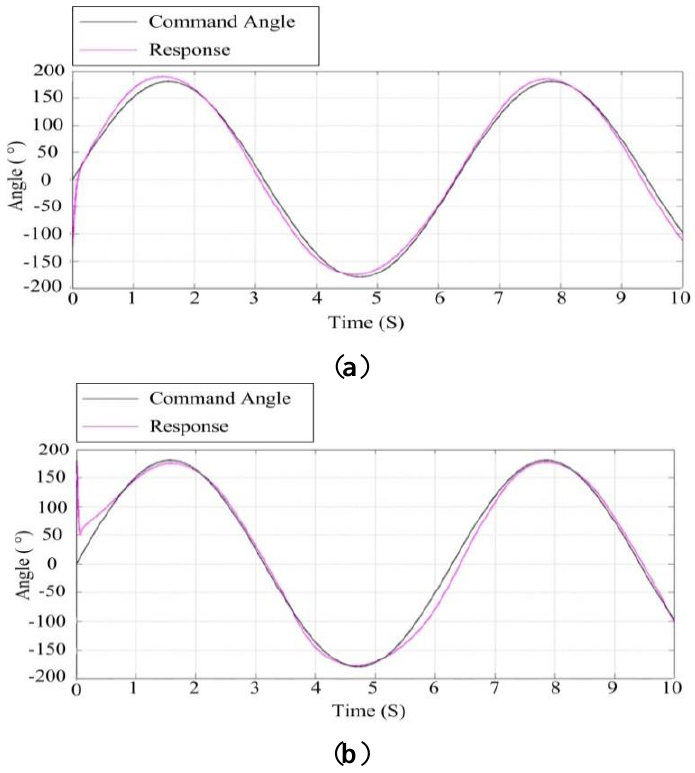
Figure 15. The response curve under roll swing of 10° sinusoidal angle of the UA: ( a ) the azimuth gimbal; ( b ) the pitch